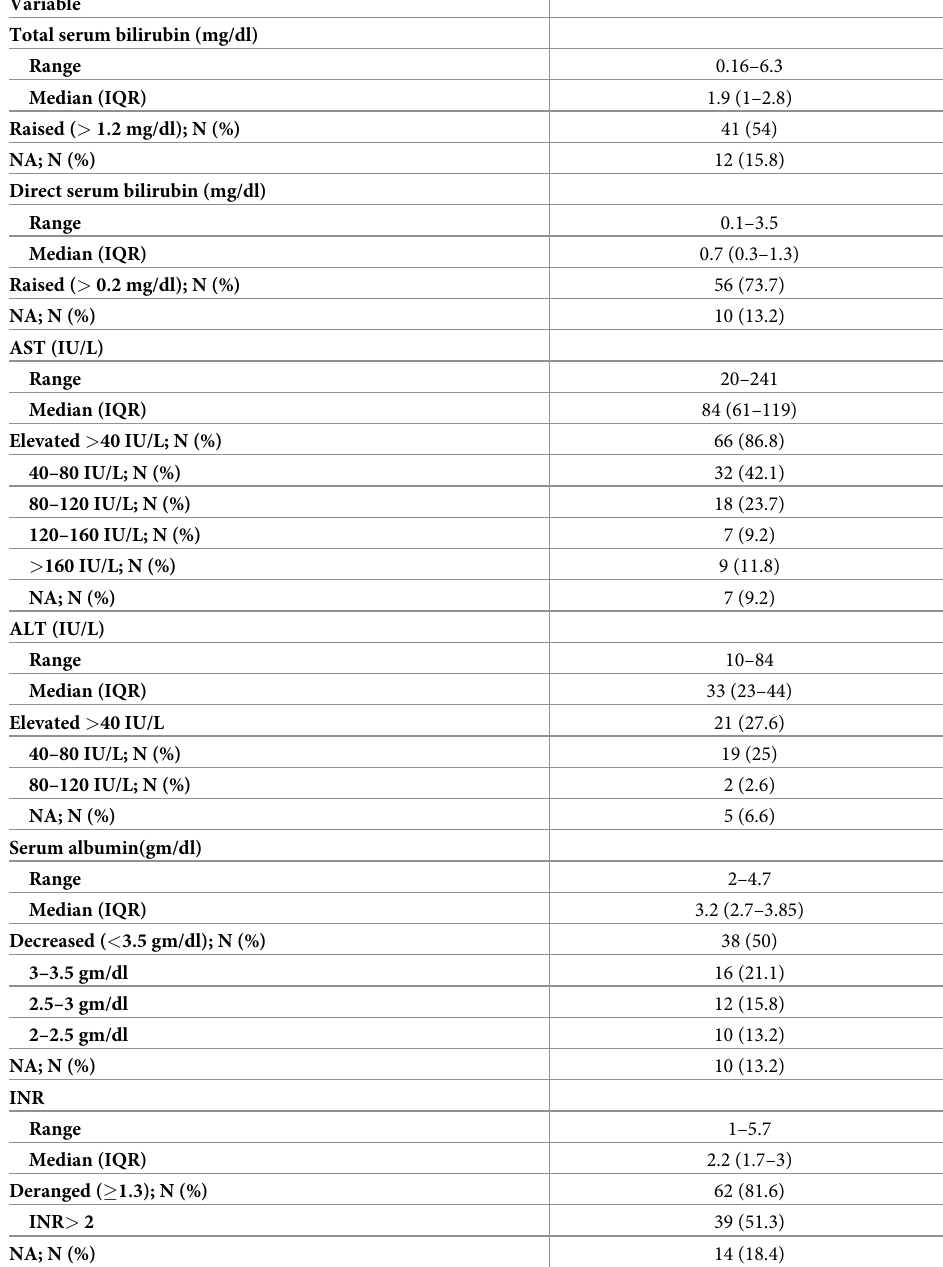
Table 3. Liver function tests of 76 hepatorenal tyrosinemia